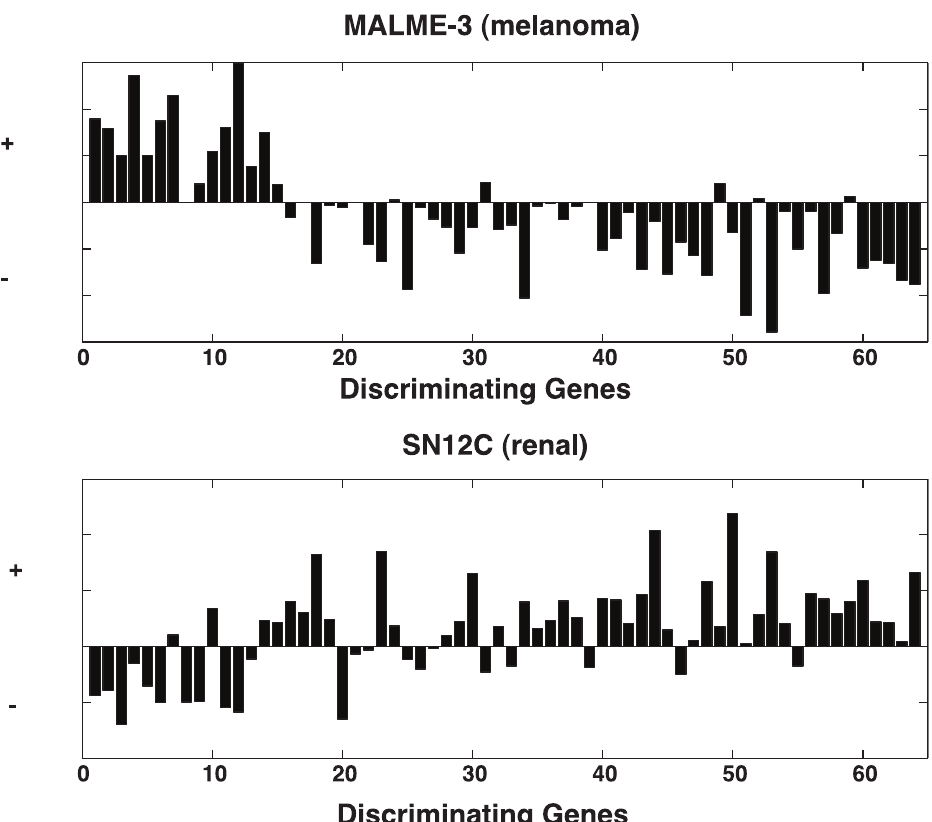
Figure 5. Discriminating gene expressions for MALME-3 (top panel) and SN12C (bottom panel). Over and under expressed genes correspond to upward and downward directed bars, respectively. Genes are divided from left to right into groups of 15 and 50 genes, respectively. An average over expression of genes in the first group and under expression of genes in the second group corresponds to MALME-3 chemo- insensitivity. The convers holds for SN12C, where an average under expression of genes in the first group and over expression of genes in the second group correspond to chemo-sensitivity.